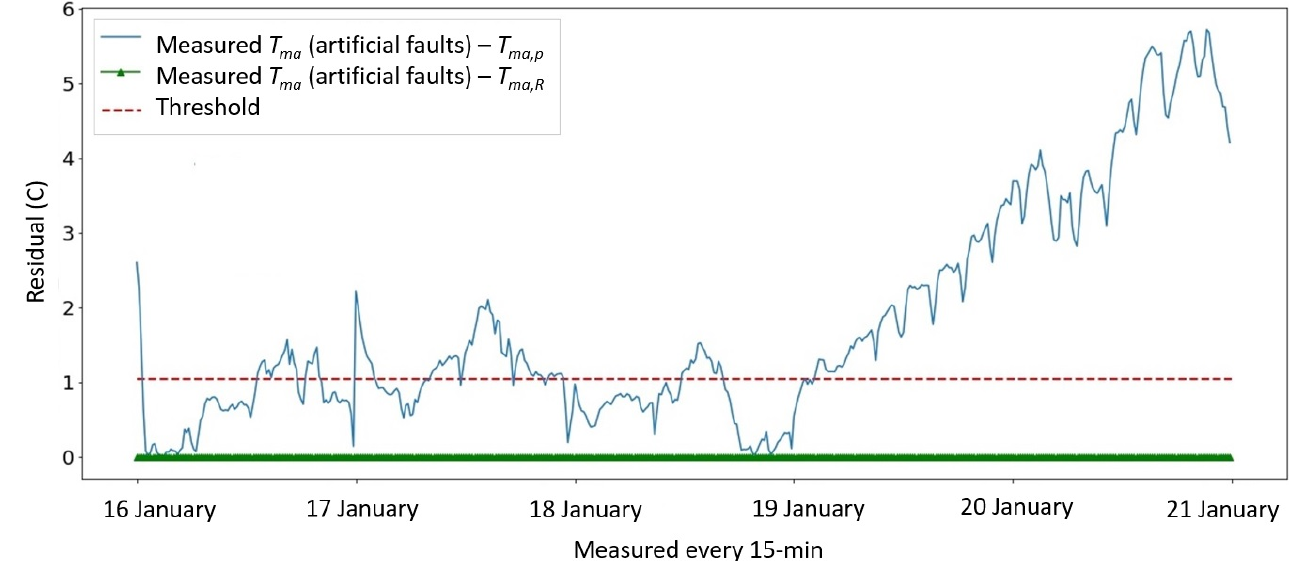
Figure 16 . Residual between measurements of T ma and predictions of T ma using RNN model . Figure 16. Residual between measurements of T ma and predictions of T ma using RNN